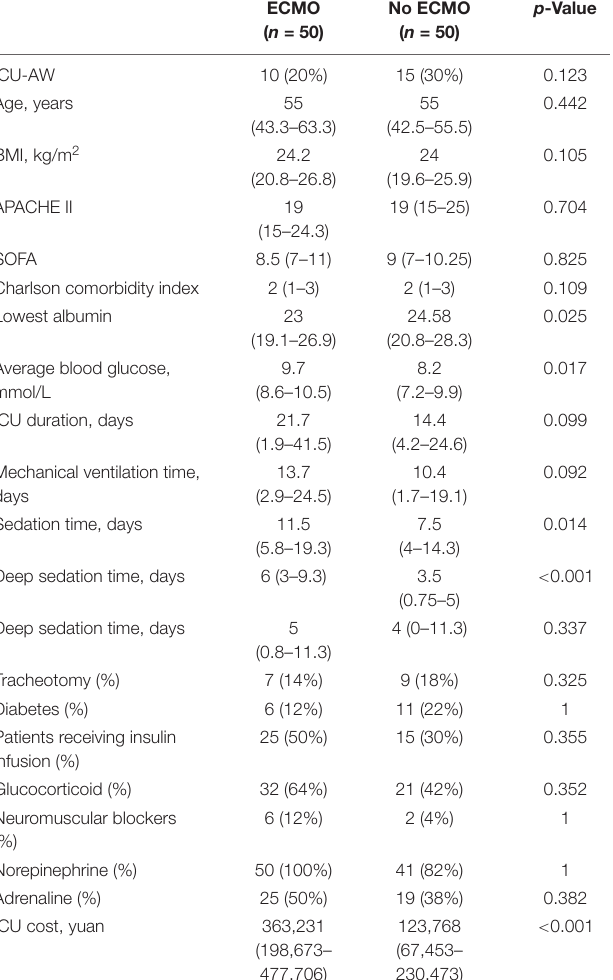
TABLE 4 | Comparison of the occurrence of ICU-AW and clinical characteristics between patients with ECMO support and without ECMO support. ECMO ( n = 50)